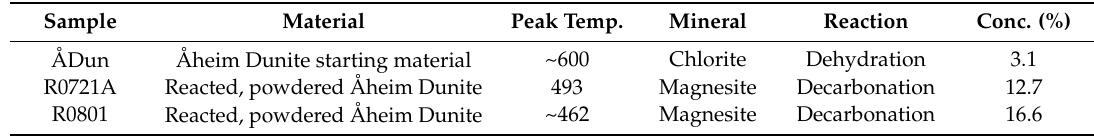
Table 9. Results of TGA analyses performed on starting materials, reacted samples and precipitates. Whereas the uncertainty in the gravimetric measurement is > ± 1%, the uncertainty introduced in interpretation of the data is ~ ±